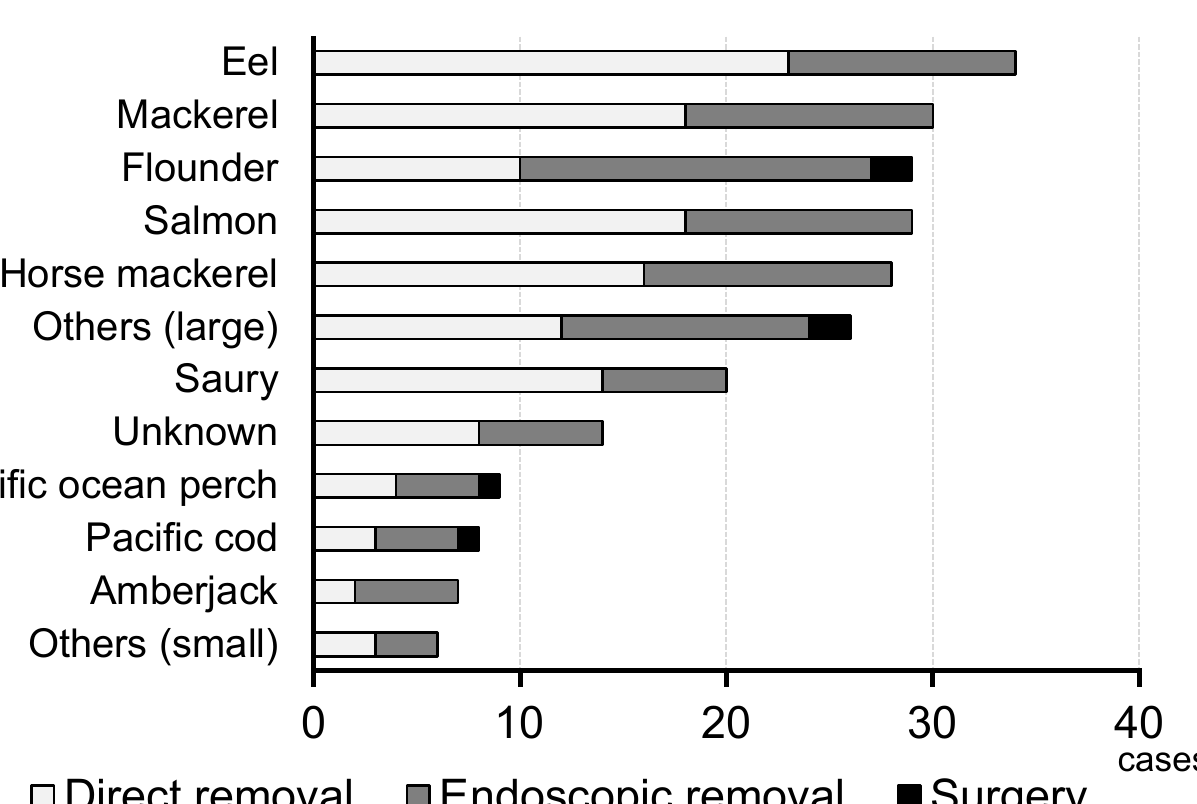
Fig 5. The removal methods of fish-bone foreign bodies. The proportion of cases involving direct removal was significantly lower in the flounder group (flounder vs. the others, p =